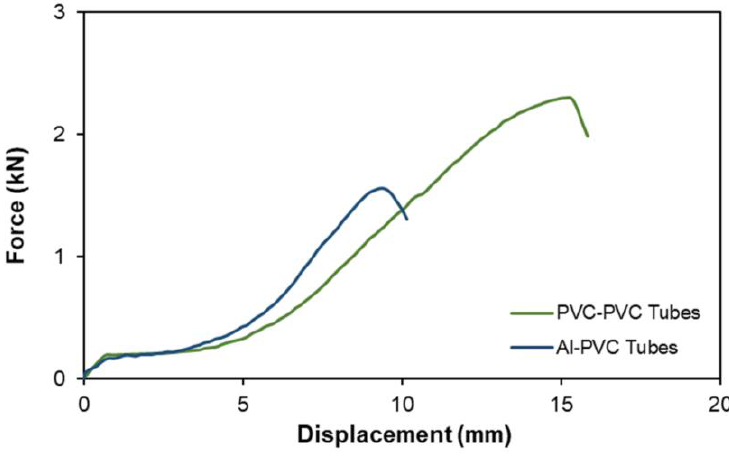
Figure 11. Leak-tightness performance for a PVC – PVC and a PVC – Al tube connection.